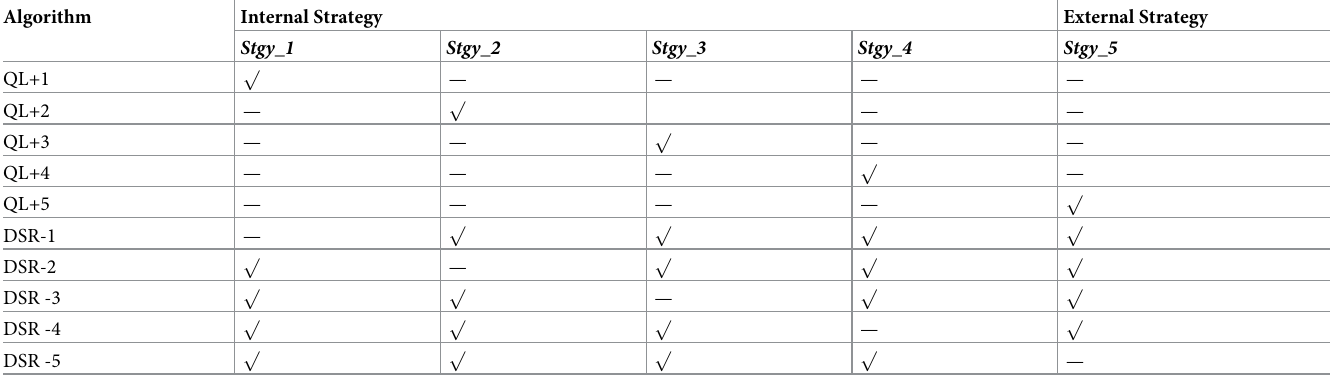
Table 6. Table of relationships between algorithms and five strategies for two experimental groups. Algorithm